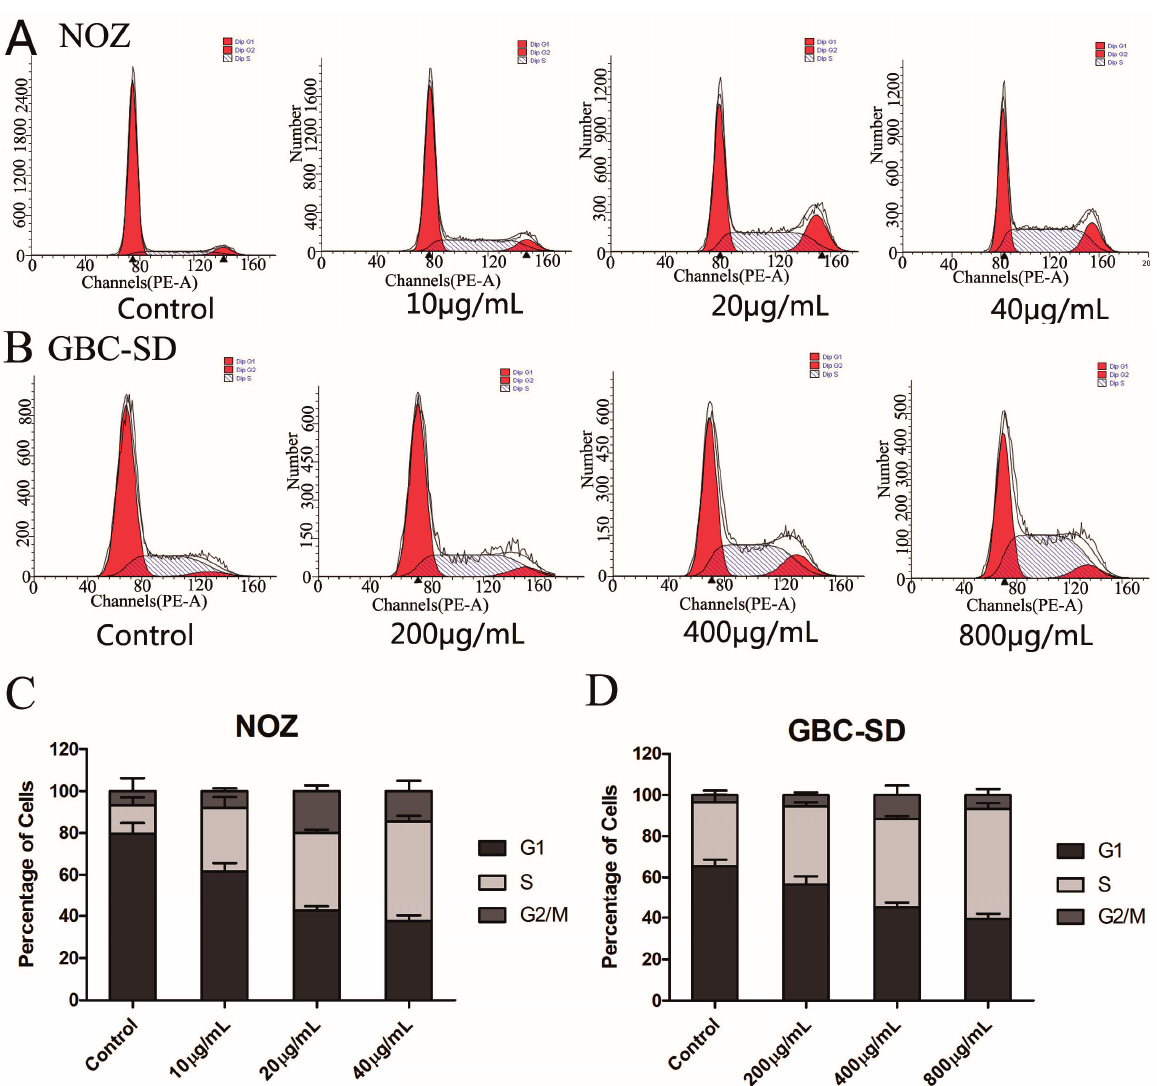
Figure 3. Cordycepin induces S phase arrest and regulates the expression of cell cycle-related proteins in gallbladder cancer